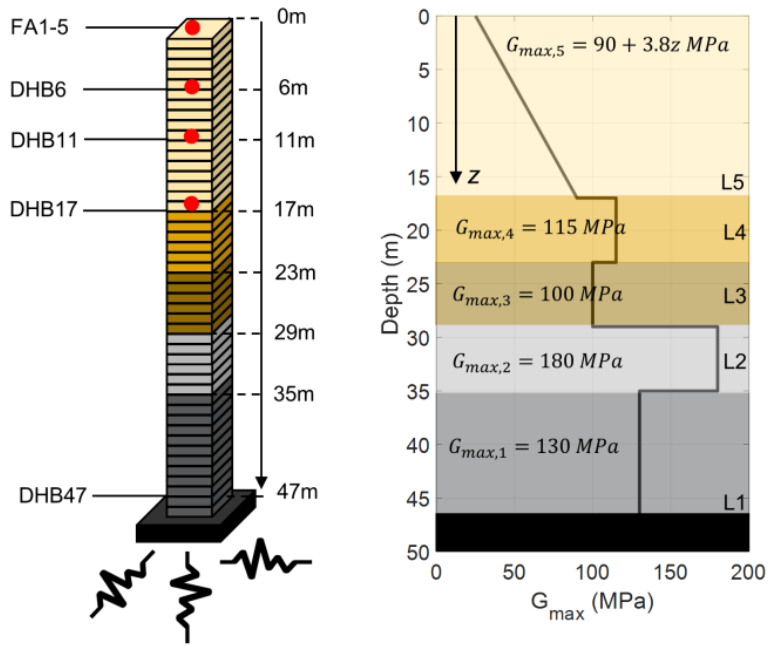
Figure 18. The FE model of the first 47 m of the Lotung site with a fixed bottom condition ( left ) and elastic shear modulus profile ( right ) (data to create the curve are from [43]).